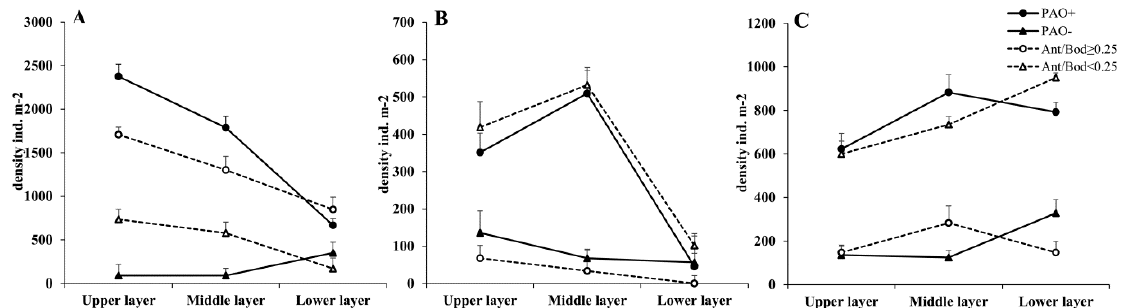
Figure 6. Vertical distribution of springtail’s PAO and antenna length/body length in ( A ) spring, ( B ) summer, and ( C ) autumn. PAO+ = Collembola with PAO, PAO − = Collembola without PAO, Ant/Bod ≥ 0.25 = Collembola with a long antenna (length ratio of antenna/body ≥ 0.25), Ant/Bod < 0.25 = Collembola with a short antenna (length ratio of antenna/body < 0.25). The values are the means ± SE.